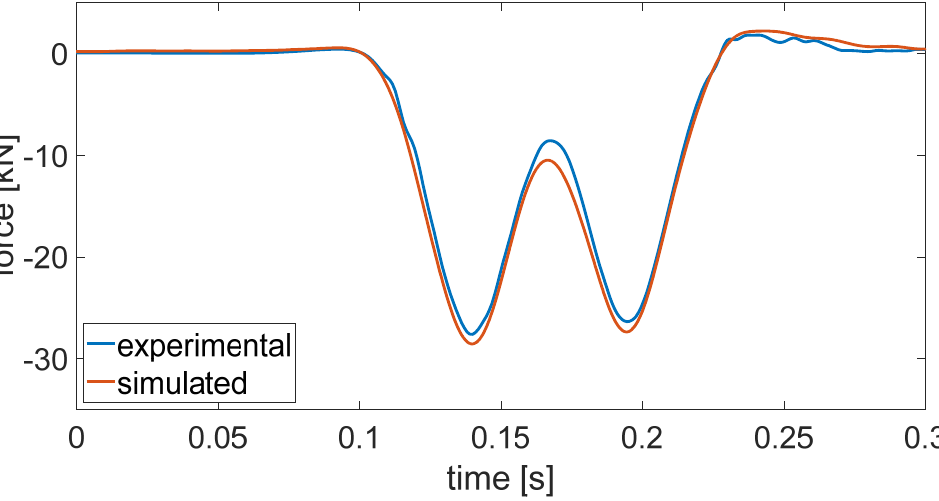
Figure 8. Comparison of the experimental and numerically simulated external force time histories applied on the 750 mm long ERS sample to realise a rail displacement simulating a train passage (ETR 500 coach at 200 km/h).